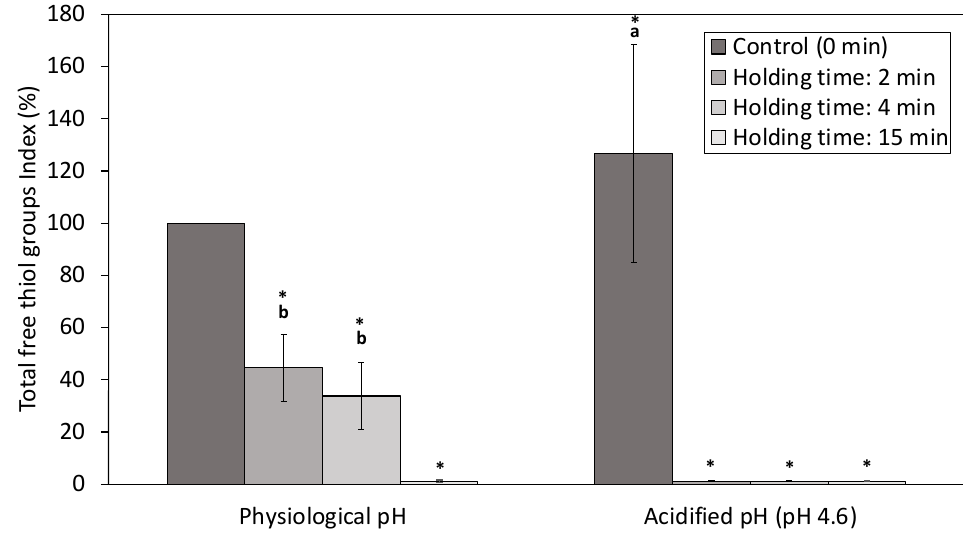
Figure 5. Second experiment. Total free thiol groups index of native whey concentrate supernatant (NWC sup ) after HPP treatments (0, 2, 4 and 15 min; 600 MPa; 23 °C) of NWCsup, at physiological pH and acidified at pH 4.6. (Mean values ± standard deviation, n = 4). a,b indicate significant differences between means ( p < 0.05) according to Tukey test. * Significant differences with untreated samples. However, under our conditions, the TFT i was significantly reduced ( p < 0.05) for both NWC sup at physiological and acidic pH after HPP treatment (600 MPa, 23 ◦ C) for all holding